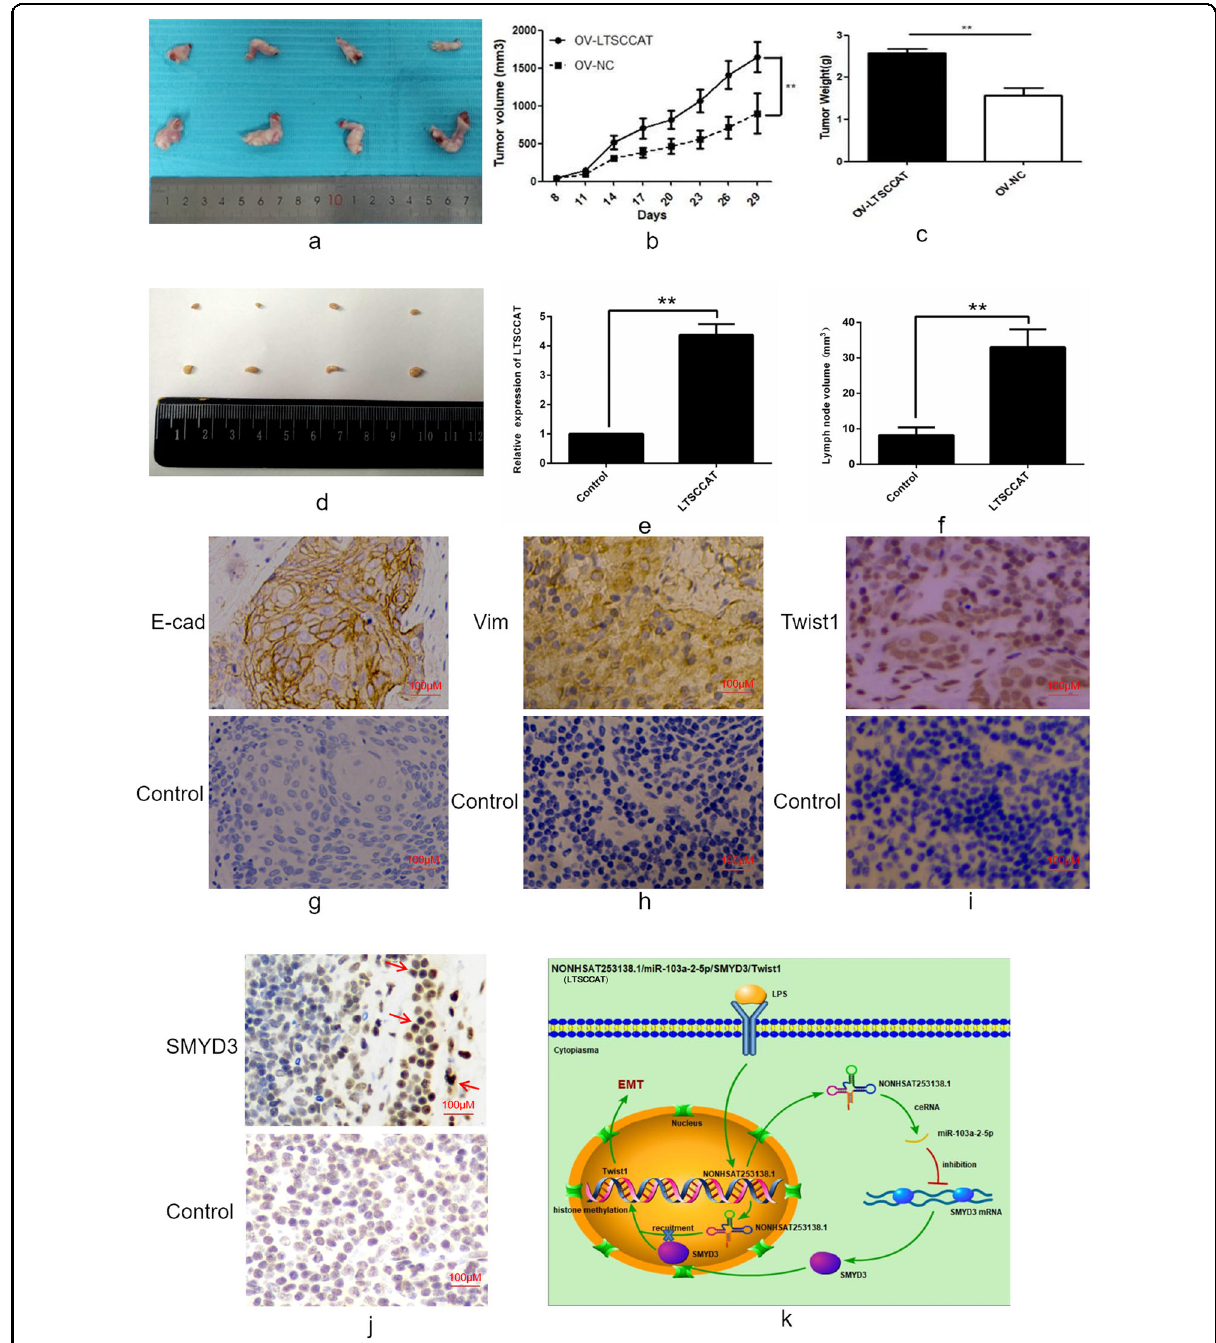
Fig. 7 LTSCCAT has a signi fi cant impact on tumor development and metastasis in vivo. a Morphology of footpad transplanted tumors in mice inoculated with LTSCCAT overexpression CAL27 and negative control CAL27 cells. b Comparison of the size of transplanted tumors in overexpressed LTSCCAT group and control group over time. c The average weight of transplanted tumors in the overexpressing LTSCCAT group was greater than that in the control group. d The lateral axillary lymph node morphology of the inoculated LTSCCAT overexpression group and control group mice. e The expression level of LTSCCAT in the LTSCCAT overexpression group of transplanted tumors was higher than that in the control group. f The size of axillary lymph nodes in the LTSCCAT overexpression group was greater than that of the control group. g Immunohistochemistry showed the expression of E-cadherin in transplanted tumors. h Immunohistochemistry showed the expression of vimentin in transplanted tumors. i Immunohistochemistry showed the expression of Twist1 in transplanted tumors. j Immunohistochemistry showed the expression of SMYD3 in transplanted tumors. k Proposed model of the role of LTSCCAT in TSCC